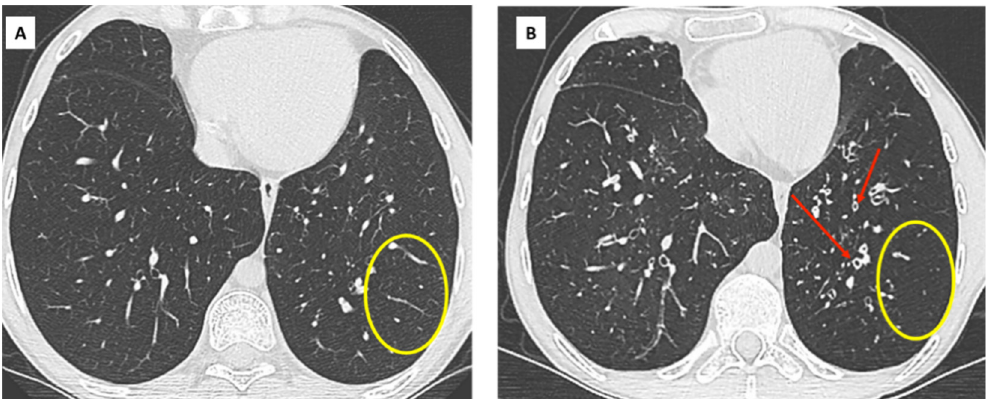
Figure 2. A 32-year-old man, bilateral LT in 2009 for cystic fibrosis. Diagnosis of BOS in 2011. ( A ) CT scan in January 2012 (FEV1 48%) shows no evidence of small or large airway disease; ( B ) CT scan in December 2017 (FEV1 18%, CLAD 4). Severe and diffuse bronchial wall thickening (red arrows), associated with mild bronchiectatic changes. Note the paucity of vascular markings in 2017 (yellow circles) compared to 2012 and subsequent hypoattenuation of lung parenchyma, related to small airway hypoventilation and fibrosis.